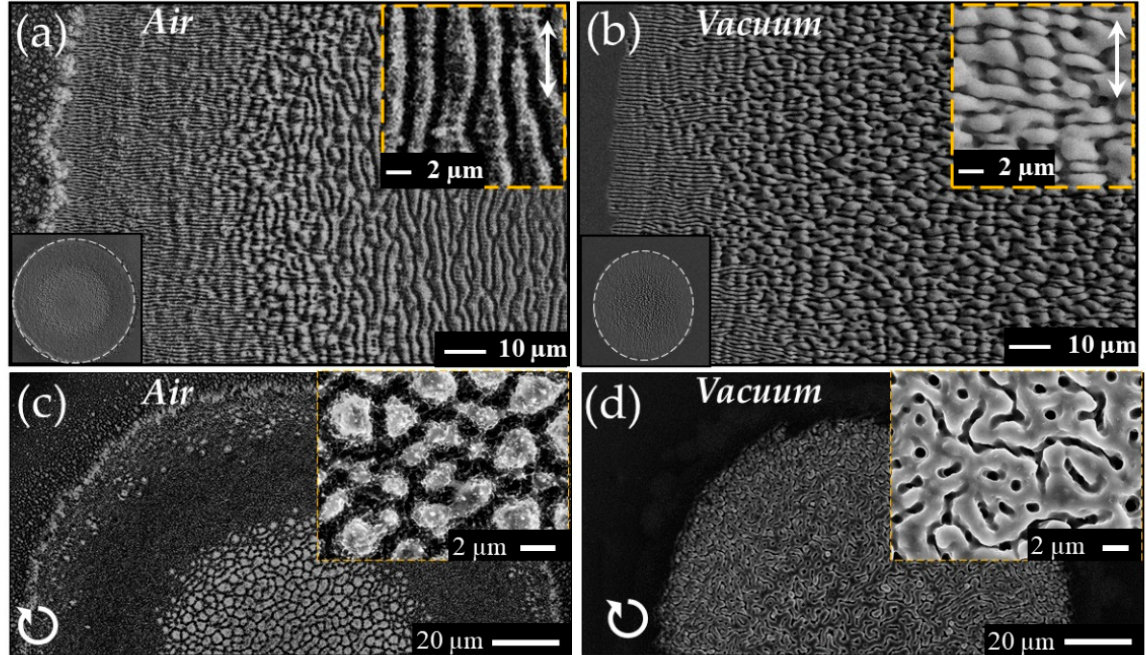
Figure 8. Examples of SEM images of surface of a silicon target irradiated with a sequence of N = 300 laser pulses at a peak fluence of ≈ 0.65 J/cm 2 in ( a ) air and ( b ) high vacuum. Panels ( a , b ) refer to a surface processed with linear polarization, whereas panels ( c , d ) are for a circular polarization, as shown by the white arrows schematically indicating the polarization state. Moreover, panels ( a , c ) are for air and ( b , d ) for vacuum, respectively. The insets in the upper right corner of each panel shows views of the surface registered at higher magnification. The insets in lower left corners of panels ( a , b ) reports SEM images evidencing the change in the shape of the shallow crater from circular to elliptic in air and vacuum, respec- tively.